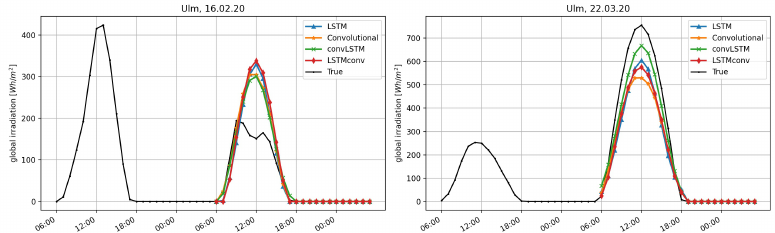
Figure 8. Global irradiation forecasts for Ulm on 16 February 2020 (left) and 22 March 2020 (right).